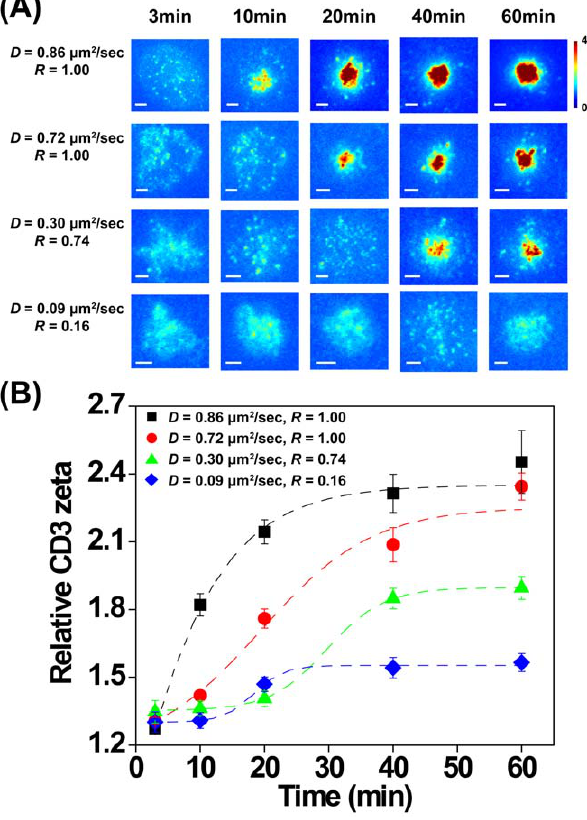
Figure 2. Ligand mobility modulates cSMAC formation and CD3 f accumulation. Jurkat T cells were allowed to interact with stimulatory surfaces for the indicated times, after which cells were fixed and labeled for CD3 f . (A) Representative TIRF images showing relative accumulation of CD3 f , are depicted using a heat map. Scale bars=3 m m. (B) Relative CD3 f accumulation in cells stimulated on the indicated membranes, plotted as a function of time. Dashed lines are sigmoidal curve fits to guide the eye. Error bars represent the standard error of the mean. N . 30 cells per condition.